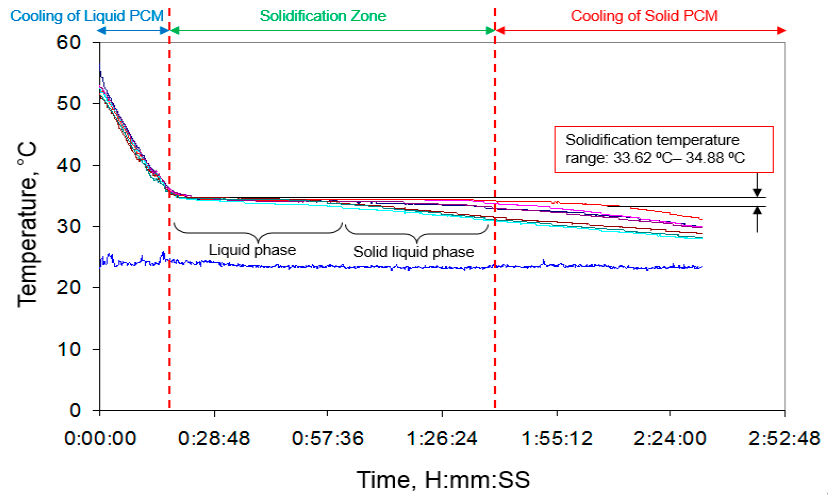
Figure 10. Solidification process of the PCM analyzed by cylindrical configuration method.